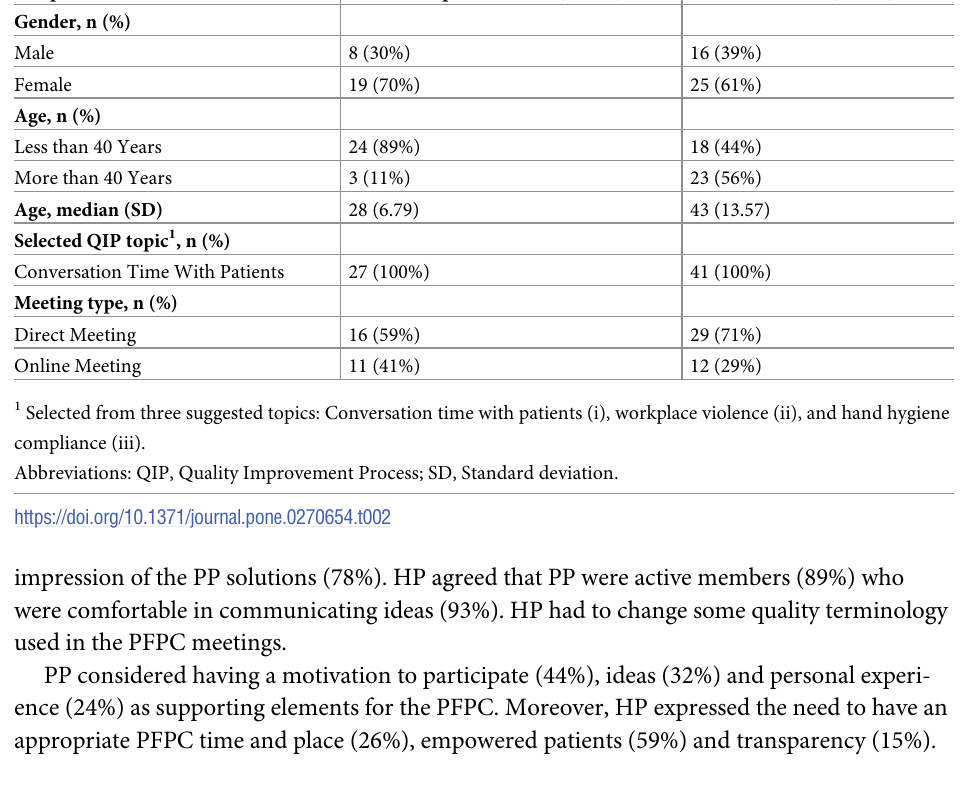
Table 2. Sample characteristics of the healthcare professionals and the patient partners. Sample